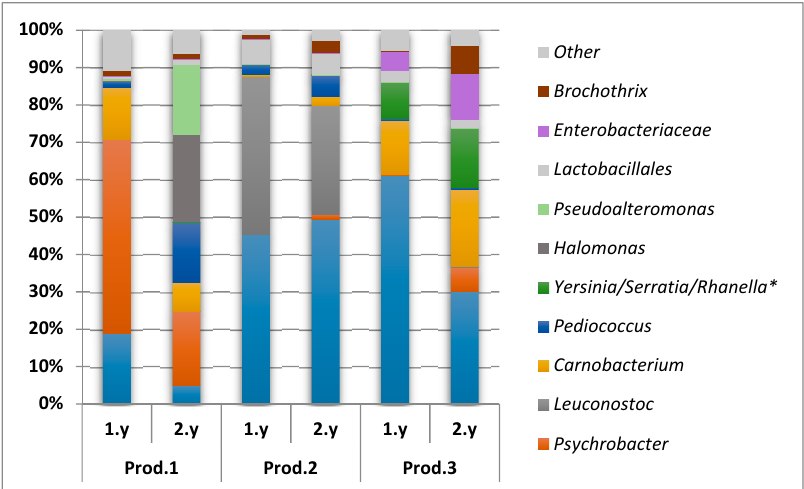
Figure 5. Dominating microbiota (all taxa above 1% across all samples) obtained from Illumina (MiSeq) of brine samples collected day 91 from the first and the second year (1.y and 2.y, respectively) from the Producers (Prod.) 1, 2, and 3. * Not possible to distinguish between these genera in the analysis.